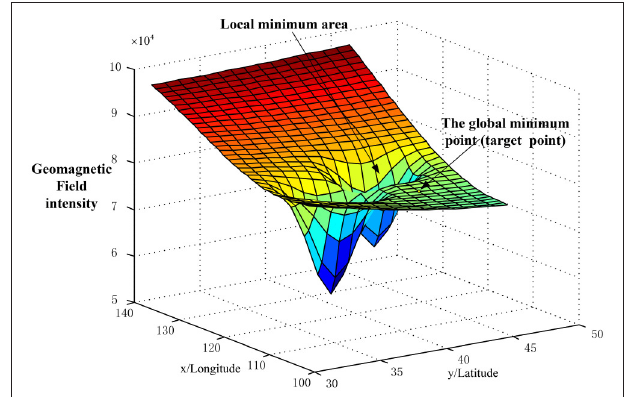
FIGURE 1 | The geomagnetic anomaly scenario.